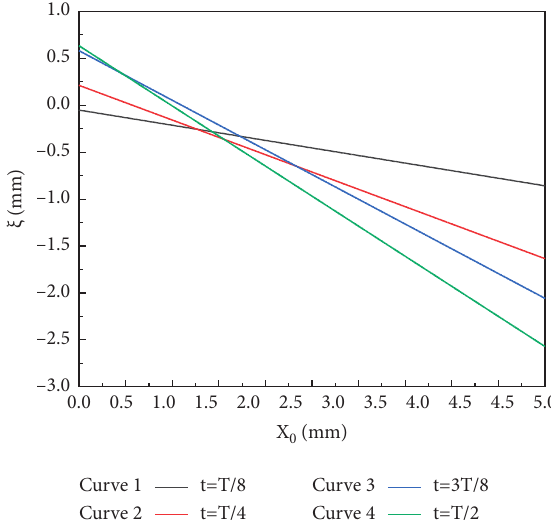
Figure 11: The relationship curve between spring precompression x and ξ 0